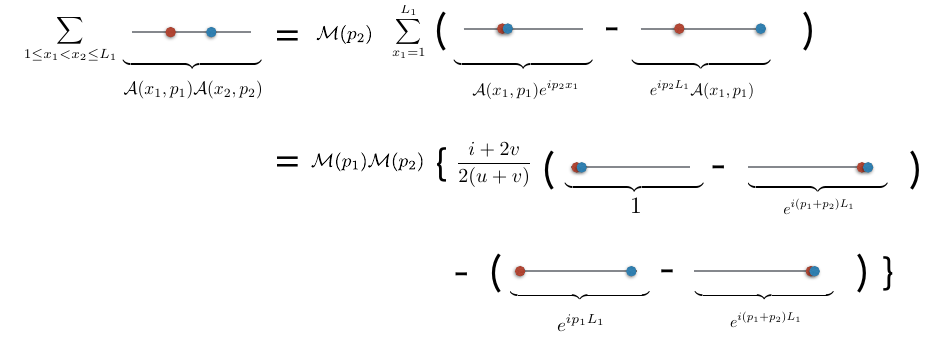
Figure 13 . Weight factor in case of the two-magnon.